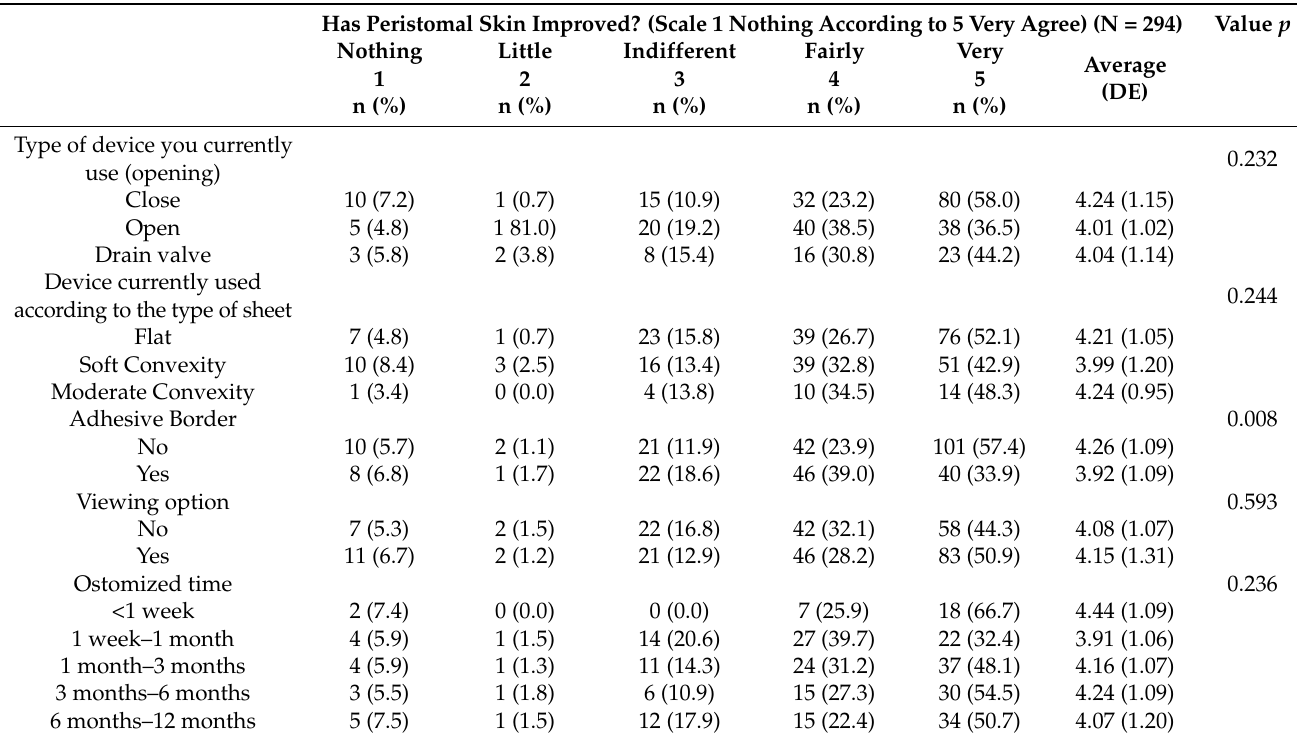
Table 6. Evaluation of peristomal skin improvement in all patients according to the type of device and some characteristics.